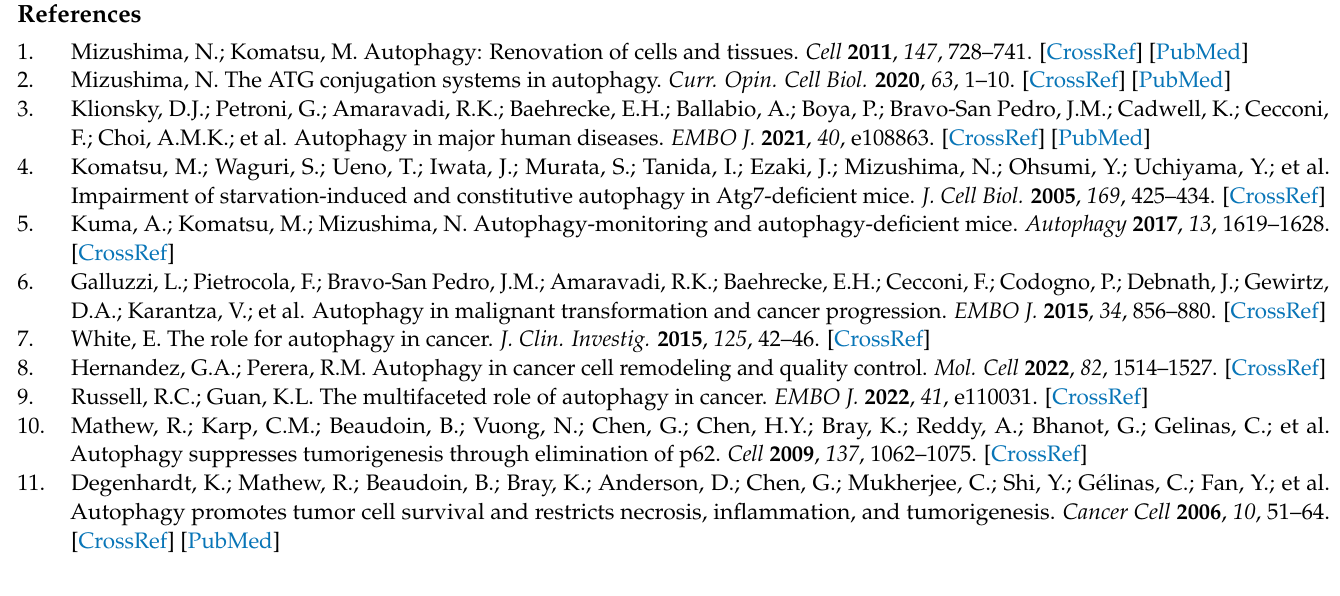
Table S2: Tumor volume of K5-SOS EGFR wa2/wa2 Atg7 f/f and K5-SOS EGFR wa2/wa2 Atg7 ∆ ep mice after wounding on both ears, including volumes after death of affected mice. Table S3: Tumor volume on each ear of K5-SOS EGFR wa2/wa2 Atg7 f/f and K5-SOS EGFR wa2/wa2 Atg7 ∆ ep